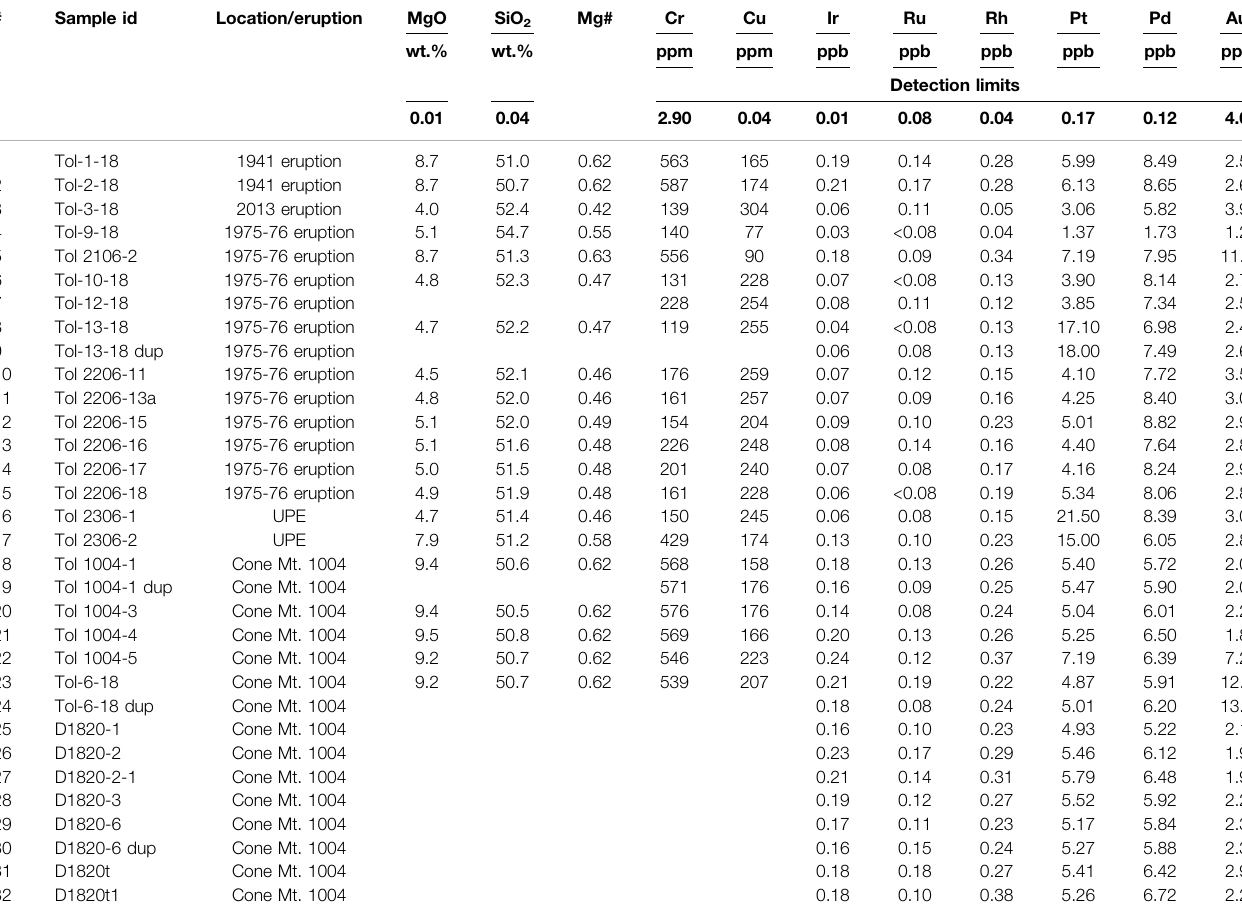
TABLE 2 | Composition of Tolbachik